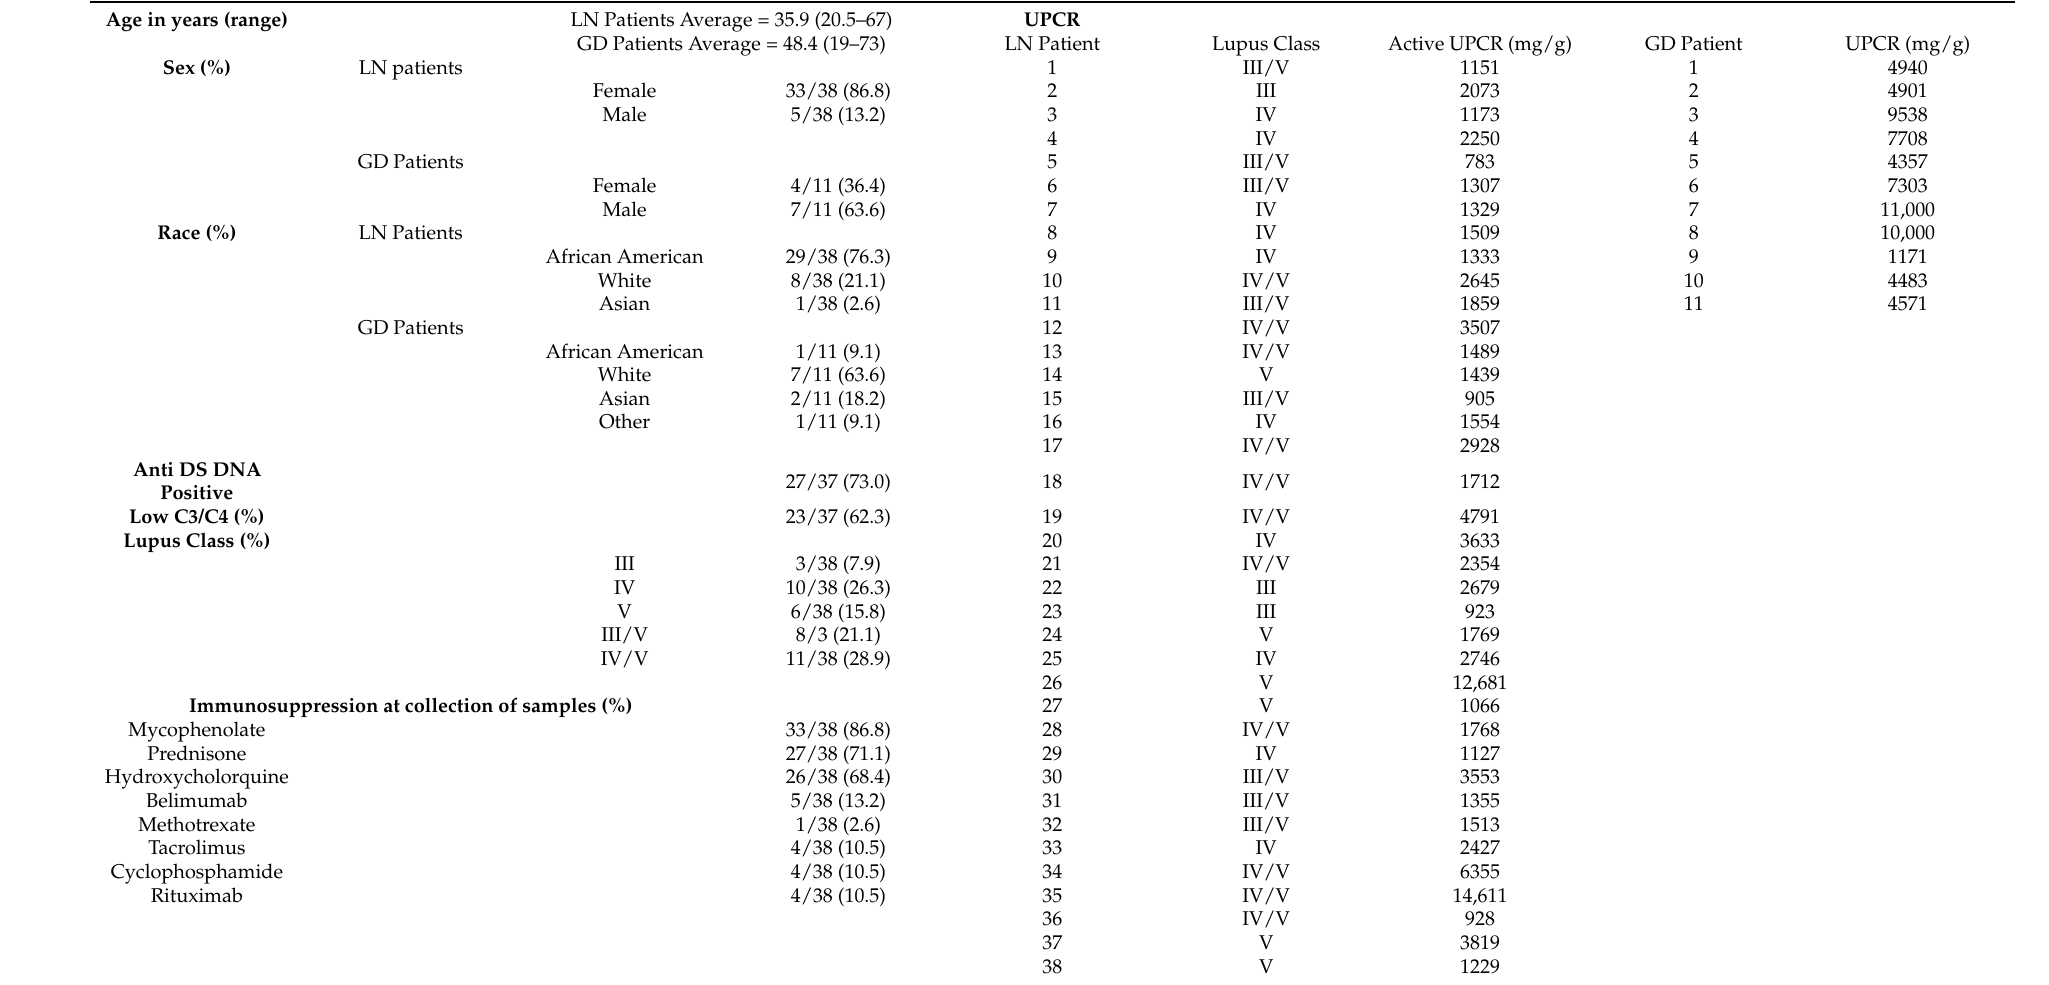
Table 1. Clinical demographics of LN and GD